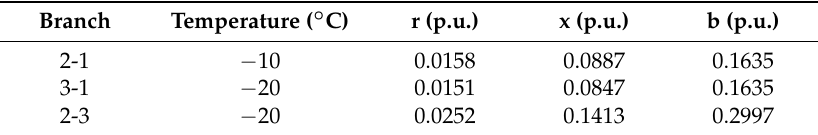
Table 6. The impedance and susceptance in case 3.